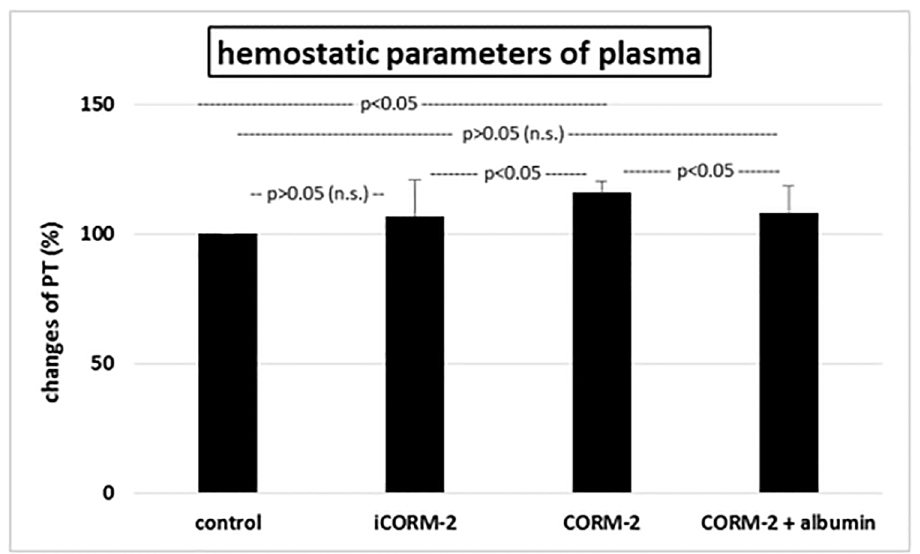
Fig 8. The effect of iCORM-2 (100 μ M, incubation time—30 min) or CORM-2 (100 μ M, incubation time— 30 min) and albumin (10%, incubation time—30 min) on the PT of plasma. In these experiments, the PT in control samples was 45.6 ± 10.2 s. Data representsmeans ± SD of 5–15 experiments (from different donors).